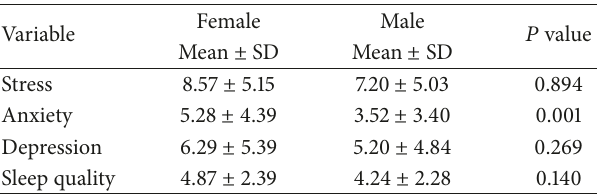
Table 2: Comparison of the mean scores of stress, anxiety, depres- sion, and sleep quality of